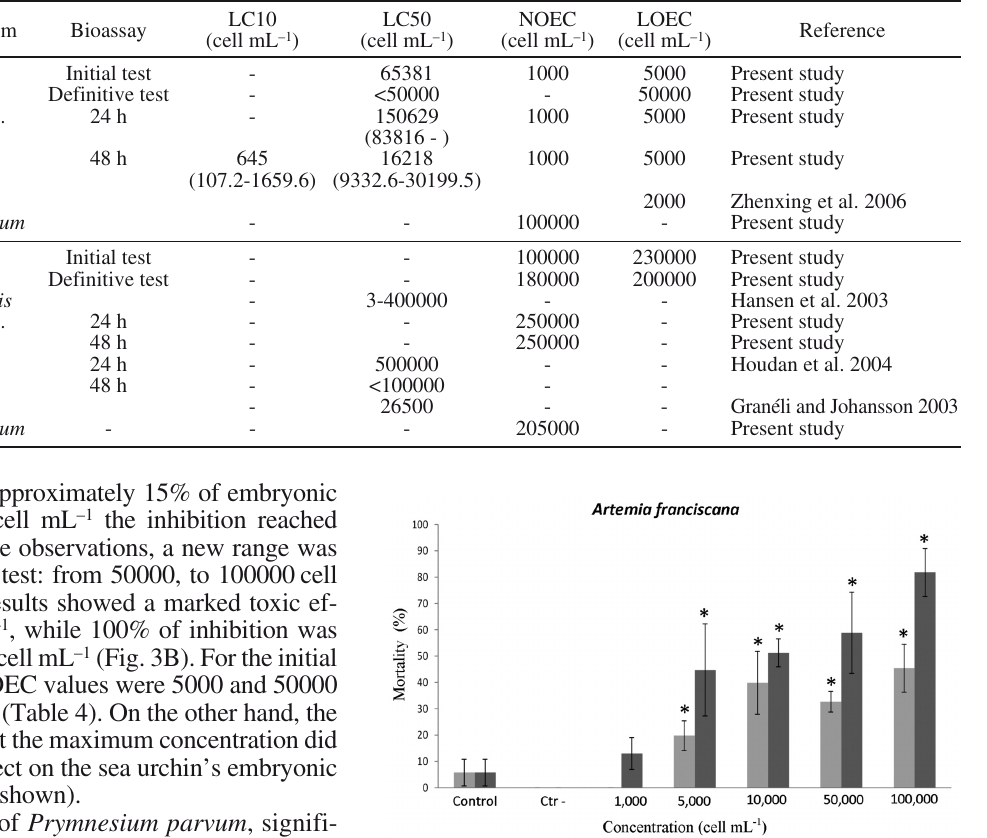
intervals (95%), NOEC (mg L –1 ) and LOEC (mg L –1 ) values.